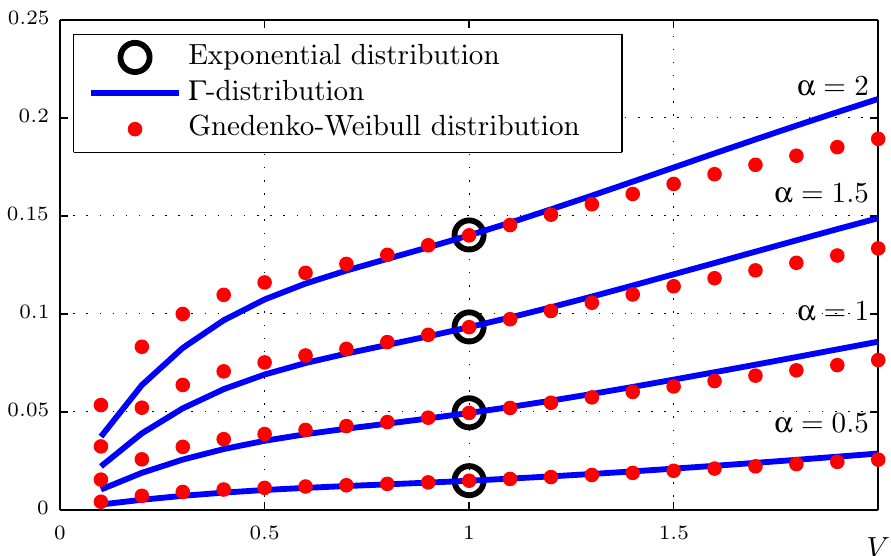
Figure 6. Probabilities of the compressor shop failure (“2-out-of-4”) for b = 20 days, g = 40